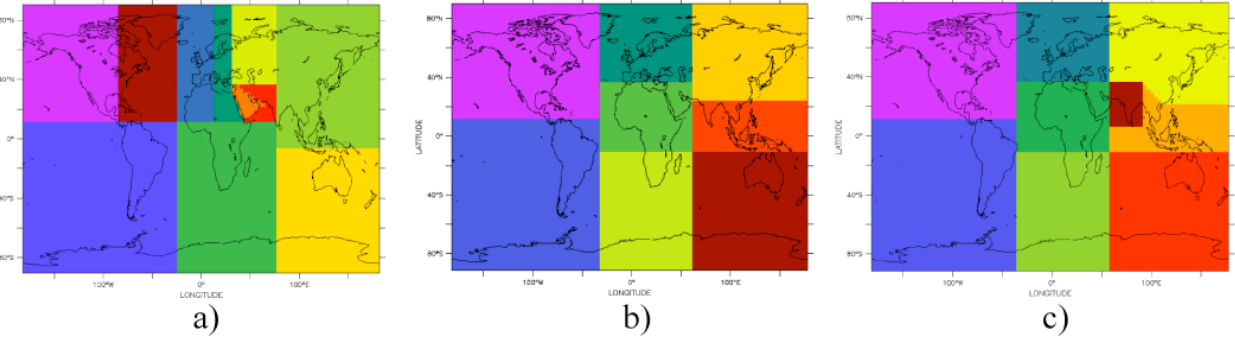
Fig. 1. Defined regions within the control vector for the emissions of desert dust (a) , the emissions of anthropogenic fossil fuel and SO 2 (b) and biomass burning (c)